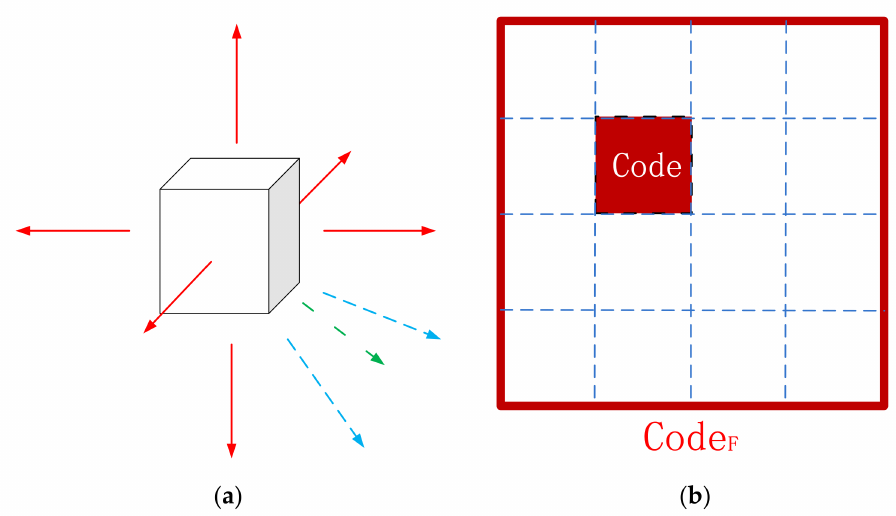
Figure 10. Spatial calculation: ( a ) neighboring directions; ( b ) geometry meaning graph for parent grid operation (in